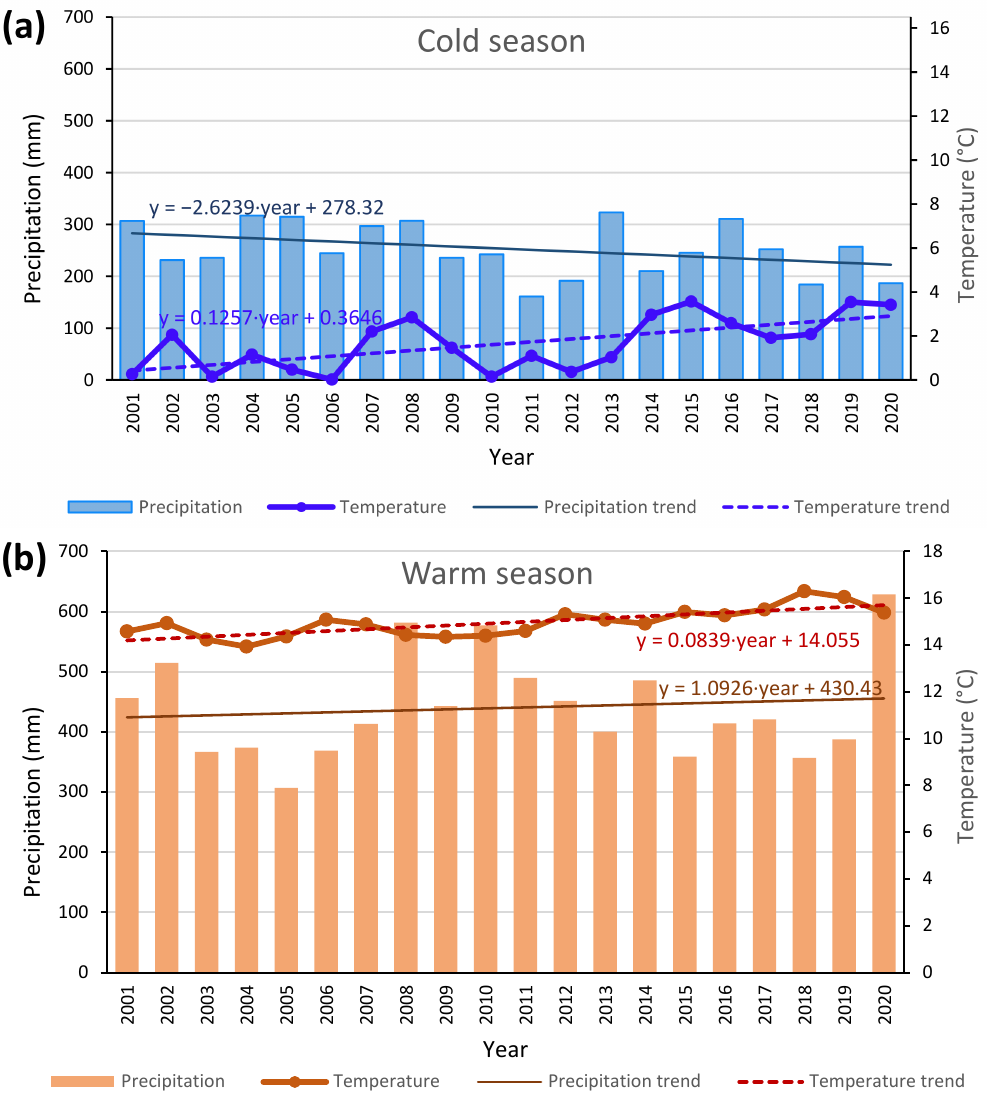
Figure 6. Changes in average total precipitation and temperature in the ( a ) cold and ( b ) warm sea- son.